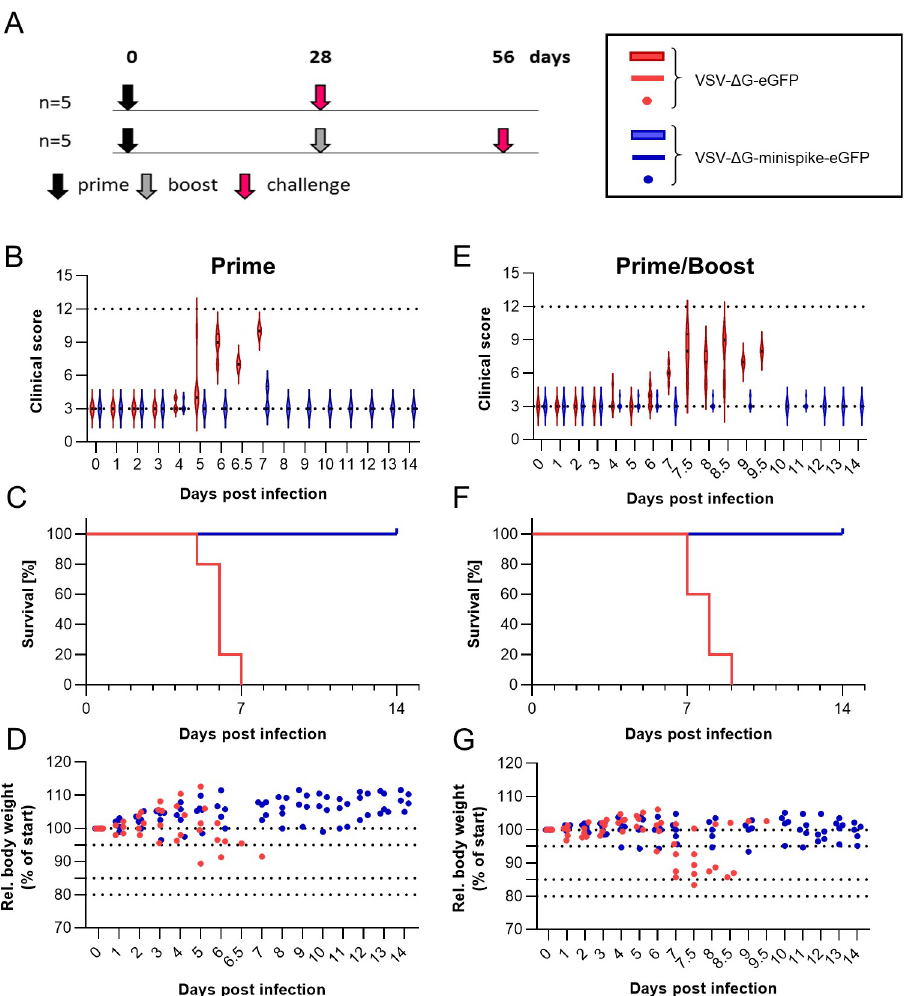
Fig 7. Protection from disease. (A) Immunization and challenge schematic. C57BL/6 K18-hACE2 mice (5 per group) were immunized (1x10 6 ffu intramuscularly) once (prime, black arrow) or twice (boost, grey arrow) four weeks apart with either VSV- Δ G-minispike-eGFP (indicated in blue in panels B-G) or VSV- Δ G-eGFP (indicated in red in panels B-G) and challenged with 1x10 4 TCID 50 SARS-CoV-2 (Wetzlar isolate) administered intranasally four weeks after the last immunization. Mice were monitored daily for development of disease for 14 days. (B-D) Evaluation of clinical disease of challenge after prime immunization. (E-G) Evaluation of clinical disease of challenge after prime/boost immunization. (B and E) Clinical score development assessed by body weight loss, general appearance, and behavior. 3: healthy; 4–6: mild disease; 7–9: severe disease; 10–12: moribund. (C and F) Survival plots. (D and G) Body weights of individual mice relative to the weight at challenge infection. Dotted lines indicate limits of clinical scores ( > 95%: score = 1, 85–95%: score = 2; 80–85%: score = 3; < 80%: score = 4). various S protein constructs became available. While soluble monomeric RBD protein suffered from limited immunogenicity, a tandem repeat single chain construct enhanced immunoge- nicity [80]. A soluble trimeric RBD, as applied in BNT162b1 mRNA clinical trials, showed very promising immunogenicity including stimulation of antibodies and T cell responses [81,82]. In addition to trimerization, membrane anchoring seems to further improve immuno- genicity, as transmembrane anchored prefusion-stabilized full-length S protein was reported to elicit higher VNA levels than corresponding secreted constructs [1,83]. Both in terms of immunogenicity and potential association of circulating SARS-CoV-2 S1 subunit with enhanced blood clotting [84], use of a small membrane-anchored antigen is rational.